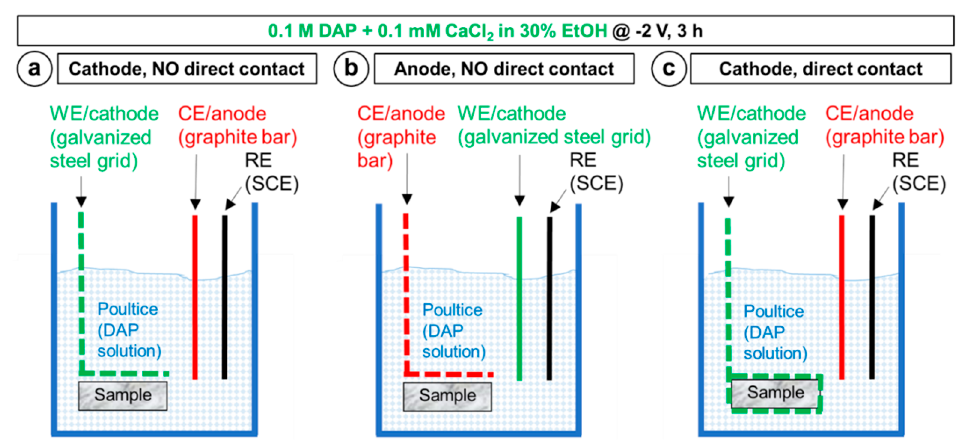
Figure 3. Schemes illustrating the different setups adopted to determine the best setup conditions: In ( a ) and ( b ), the role of the working electrode (the galvanized steel grid) is switched, to determine whether the marble sample should be placed near the cathode or near the anode; in ( a ) and ( c ), the marble sample is always placed near the cathode, but either at ~3 mm distance from the electrode or directly in contact, to determine whether direct contact is preferable or not. The setup in ( a ) was also adopted to compare potentiostatic and galvanostatic conditions.